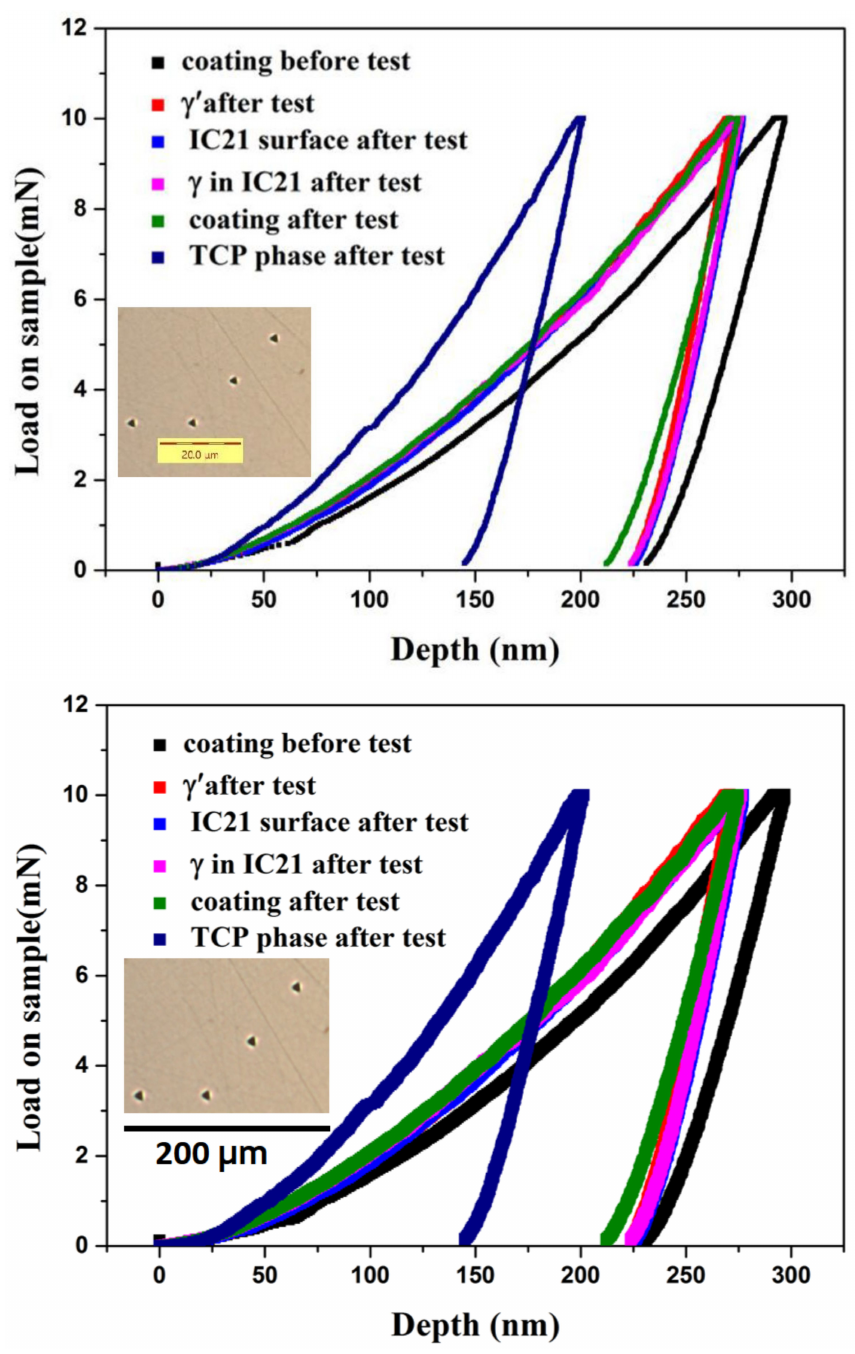
Figure 6. The load–displacement curves of different